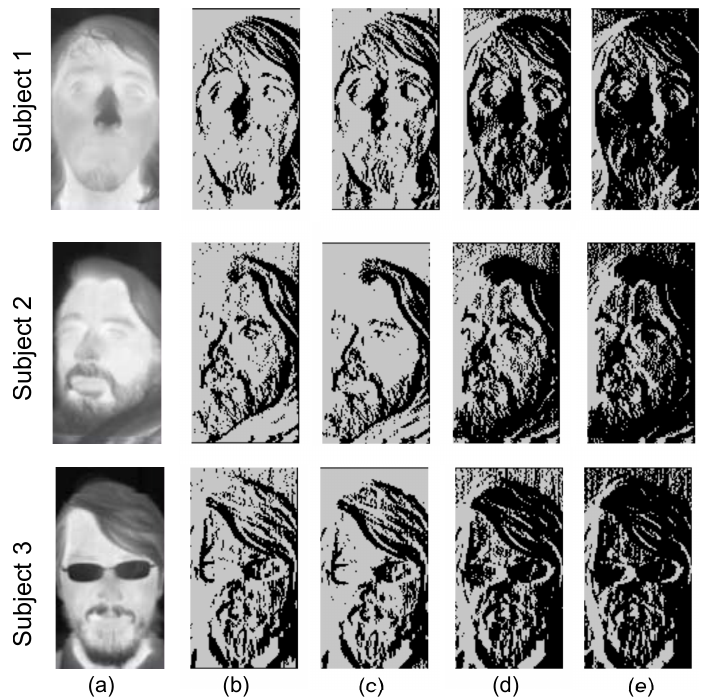
Figure 18. Effect of V ref in the RLBP values generated by the RPG for 3 images acquired using a FLIR Tau 2 thermal IR core. ( a ) original IR image, ( b ) RLBP image generated by software, ( c – e ) RLBP images generated by the RPG for V ref values of 1.665 V, 1.650 V and 1.645 V,